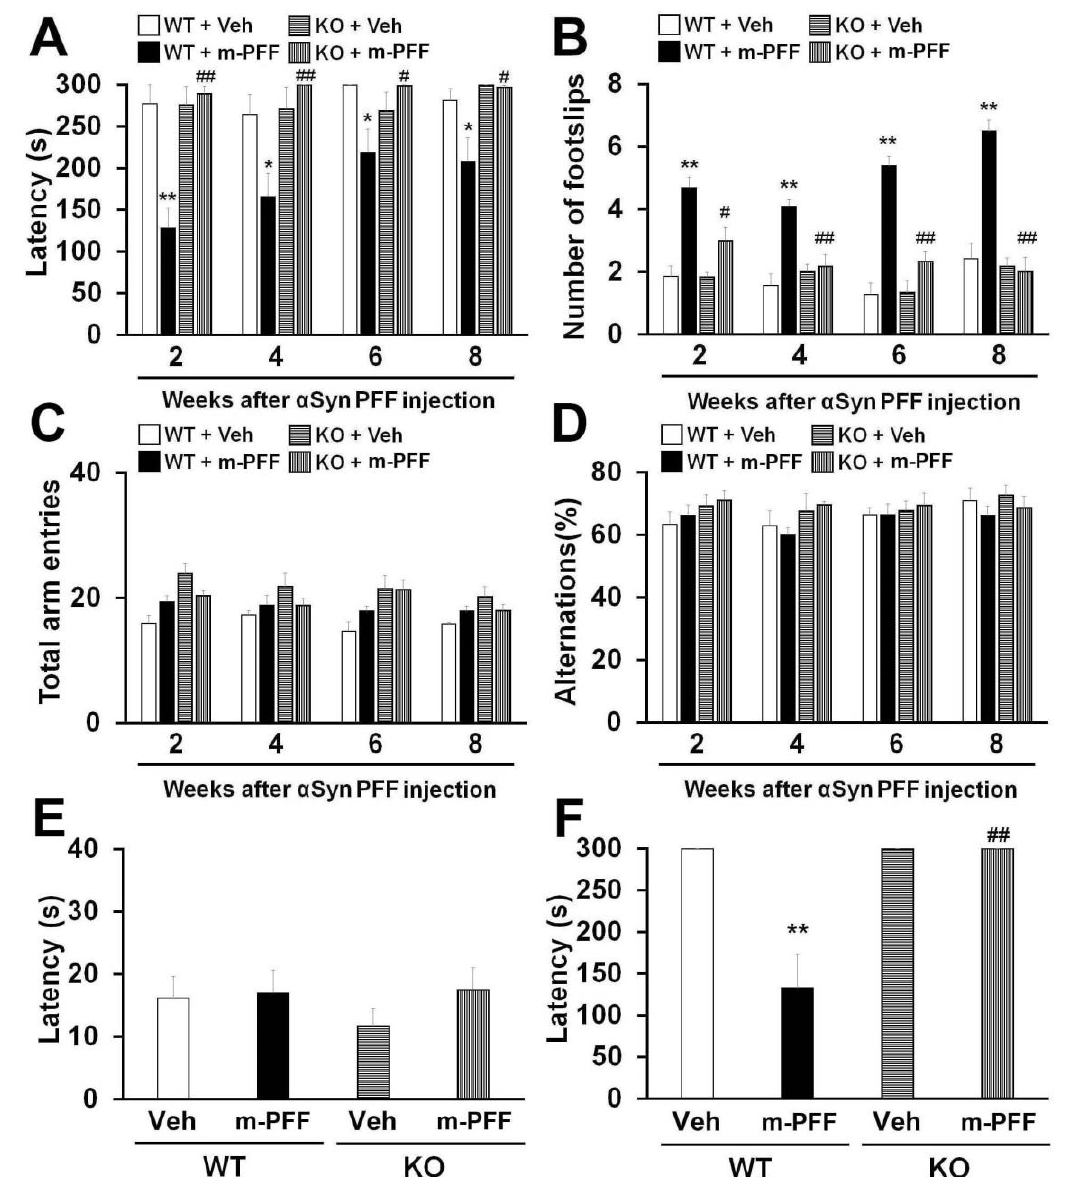
Figure 4. Fabp3 − / − mice show resistance to mouse α -Syn PFF-induced motor and memory impairments. ( A, B ) Analyses of motor function in WT and Fabp3 − / − mice based on the rotarod task ( A ) and beam walking task ( B ) at 2, 4, 6, and 8 weeks after mouse α -Syn PFF injection (WT: n = 6; mouse α -Syn PFF-injected WT: n = 10; Fabp3 − / − : n = 6; mouse α -Syn PFF-injected Fabp3 − / − : n = 6). Error bars represent SEM. ( C, D ) There were no di ff erences in the total arm entries and alternation in the Y-maze task between groups (WT: n = 6; mouse α -Syn PFF-injected WT: n = 10; Fabp3 − / − : n = 6; mouse α -Syn PFF-injected Fabp3 − / − : n = 6). Error bars represent SEM. ( E ) No di ff erences were observed in latency times in the passive avoidance task among the groups in the first trials (WT: n = 6; mouse α -Syn PFF-injected WT: n = 10; Fabp3 − / − : n = 6; mouse α -Syn PFF-injected Fabp3 − / − : n = 6). Error bars represent SEM. (F) The decreased retention time following mouse α -Syn PFF injection was significantly attenuated in Fabp3 − / − mice (WT: n = 6; mouse α -Syn PFF-injected WT: n = 10; Fabp3 − / − : n = 6; mouse α -Syn PFF-injected Fabp3 − / − : n = 6). Error bars represent SEM. * p < 0.05, ** p < 0.01 versus vehicle-injected WT mice; # p < 0.05, ## p < 0.01 versus mouse α -Syn PFF-injected WT mice. KO: Fabp3 − / − mice, m-PFF: mouse α -Syn PFF injection, Veh: vehicle injection, WT: wild-type mice.